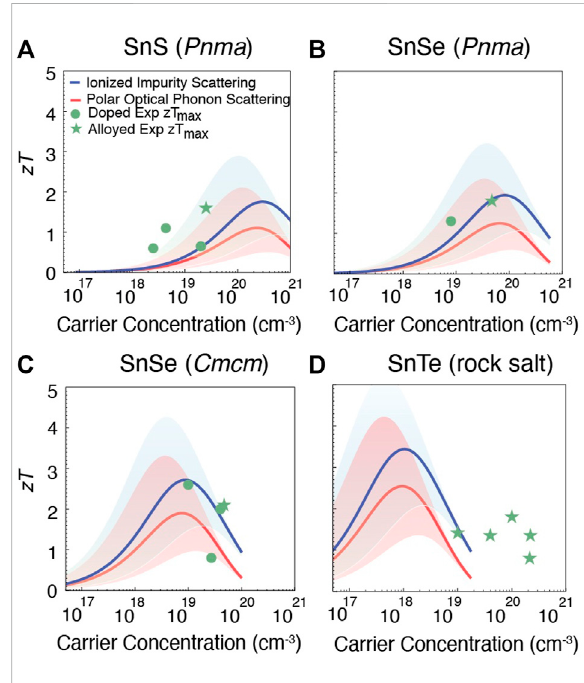
FIGURE 3 Prediction of zT for p-type (A) SnS ( Pnma ), (B) SnSe ( Pnm a), (C) SnSe ( Cmcm ), and (D) SnTe (rock salt). The red and blue lines show zT for polar optical phonon and ionized impurity limited carrier mobility, respectively. The shaded region accounts for the uncertainty in the predicted mobility μ 0 . The largest experimentally reported zT s for both doped (green dots) and alloyed compositions (green asterisks) are shown for comparison (Zhouetal.,2017;Tanetal.,2014;Heetal.,2019;CaiBetal.,2020; Zhao etal., 2014;2015; Qin etal., 2018;Chere etal., 2016;Al Rahal Al Orabi et al., 2016; Doi et al., 2019; Ma et al., 2019; Tang et al., 2018; Tan et al.,